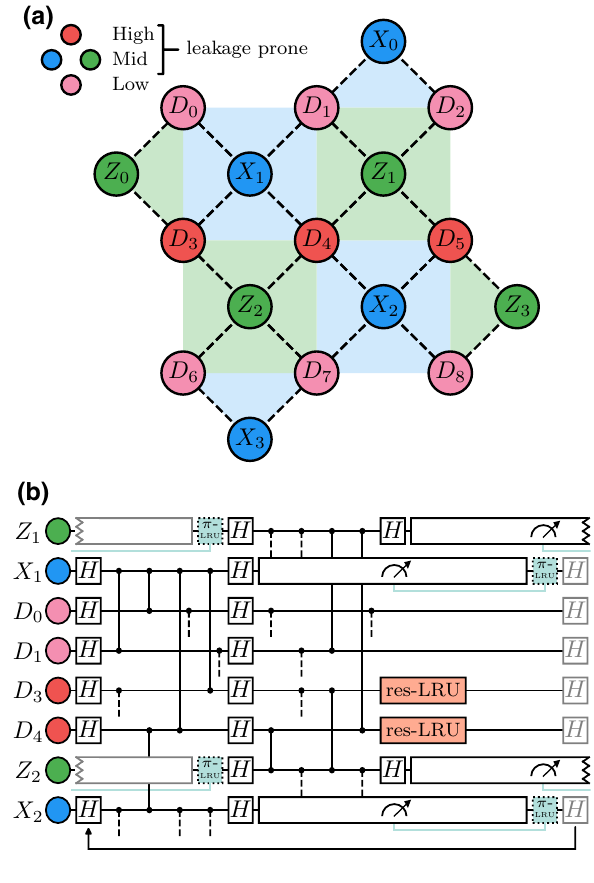
FIG. 3. (a) Schematic overview of the Surface-17 layout [46,57]. Pink (red) circles with D labels represent low- (high-)frequency data qubits, while blue (green) circles with X ( Z ) labels represent ancilla qubits, which have an intermedi- ate frequency. Ancilla qubits and high-frequency data qubits are prone to leakage during the CZ gates. (b) The quantum circuit for a single QEC cycle employed in simulation for the unit-cell scheduling defined in Ref. [57], in which we insert the LRUs. The res-LRUs (orange) are applied unconditionally on the high- frequency data qubits after the CZ gates, while the π -LRUs (teal) are applied on the ancilla qubits depending on the measurement outcome. Gray elements correspond to operations belonging to the previous or the following QEC cycle. The duration of each operation is given in Appendix C 1. The arrow at the bottom indicates the repetition of QEC